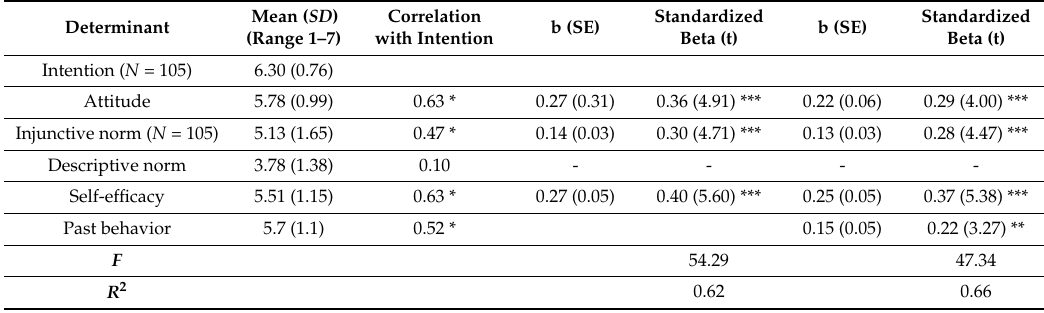
Table 3. Determinants predicting waste separation: means and standard deviations, correlations with intention, and regression to predict